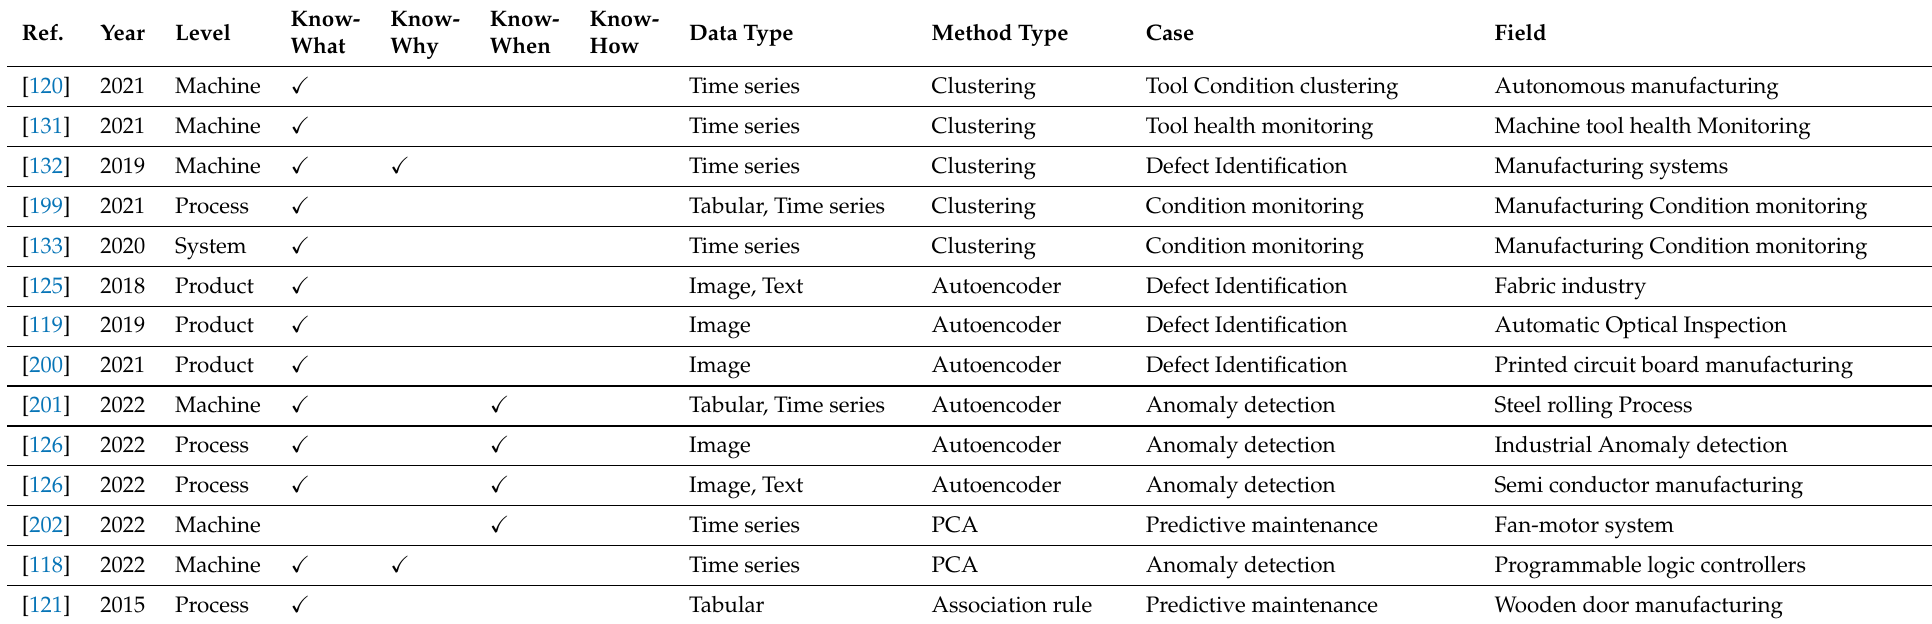
Table A2. Categories of unsupervised learning